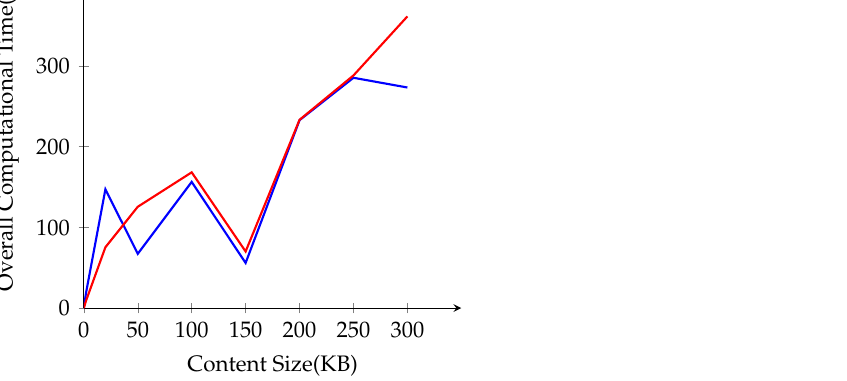
Figure 10. Overall computational time cost for different file sizes.